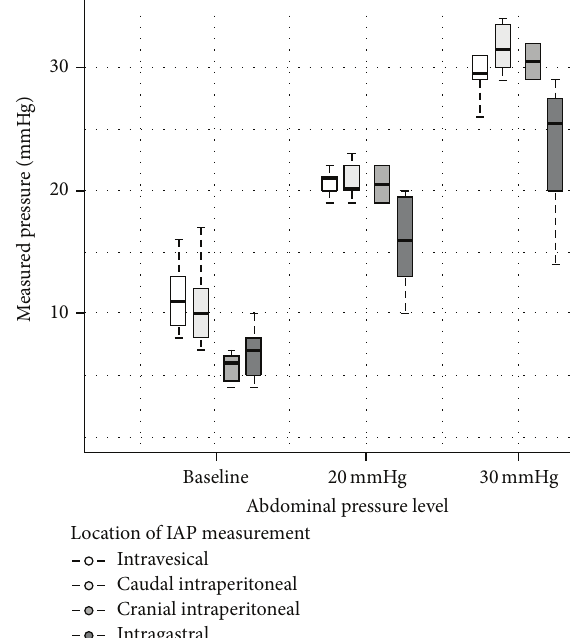
Figure 1: IAP values for all three different measurement techniques encompassing intravesical, invasive piezoresistive (intraperitoneal), and intragastric measurements (band = median, boxes = 25 to 75% quartile, and whiskers = 95% confidence interval). The intraperi- toneal probes are subdivided after their intraperitoneal implantation site.